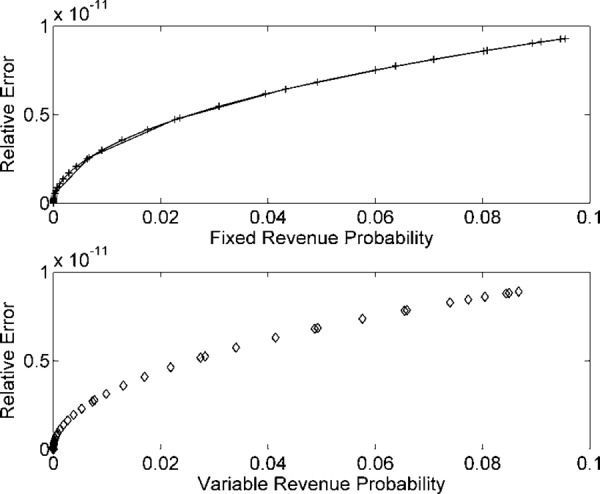
REs in RF(t) and Rv(t) probabilities for n = 107 samples.